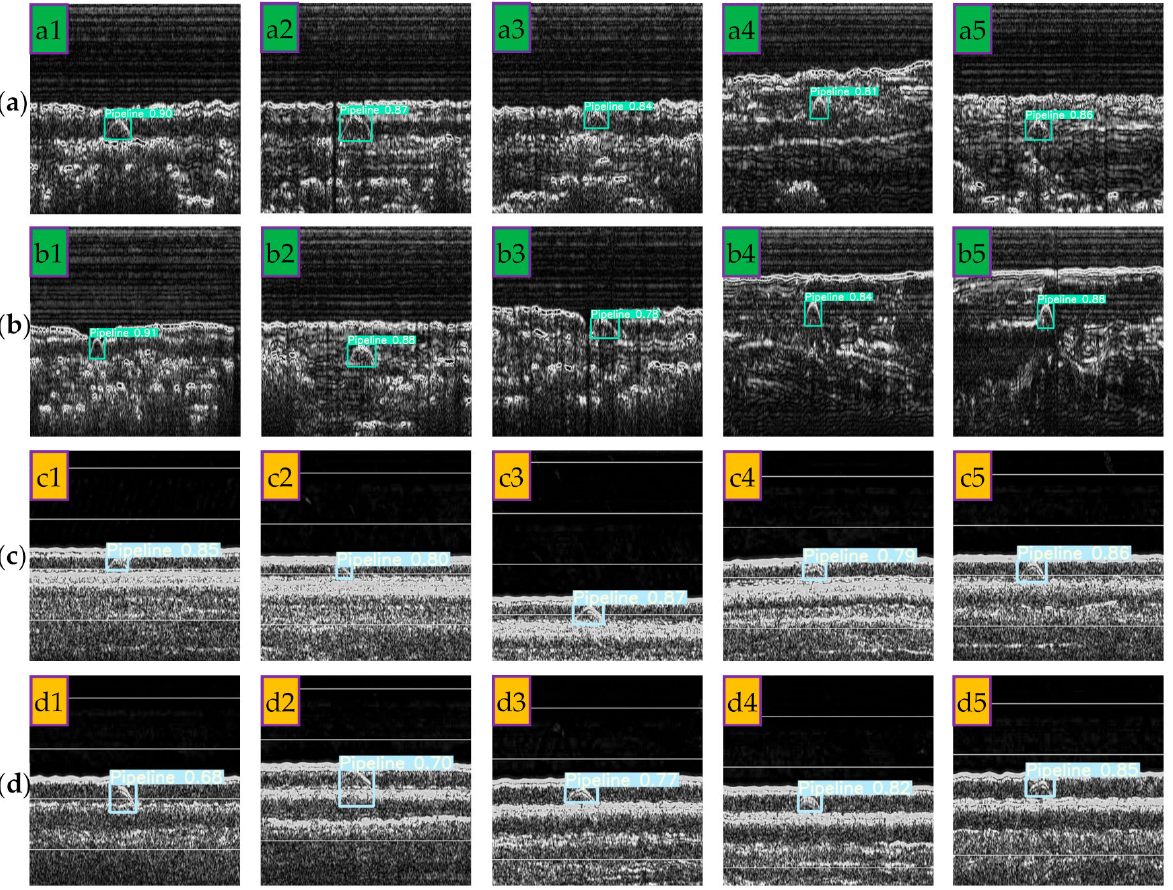
Figure 21. Part of the correct detection results on the test set. ( a , b ) Pipeline images collected by Chirp III; ( c , d ) pipeline images collected by EdgeTech